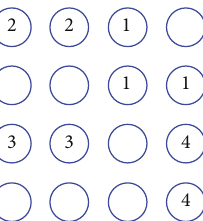
i s; each symbol